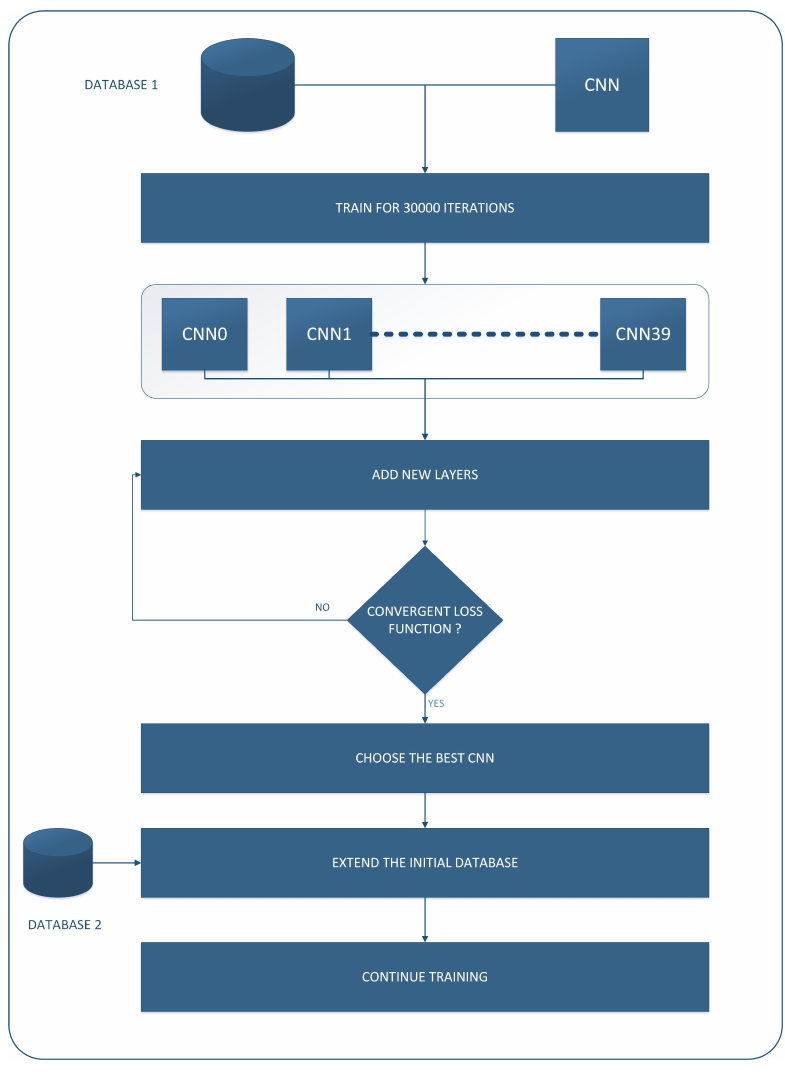
Figure 7. Diagram of proposed